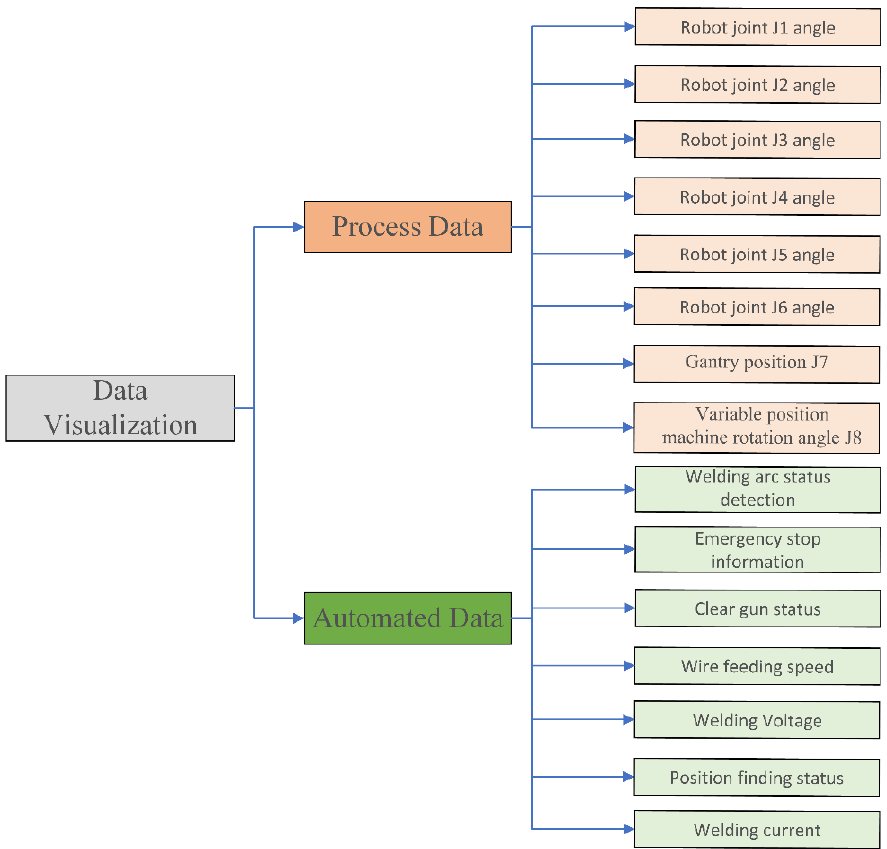
Figure 6. Dynamic data.